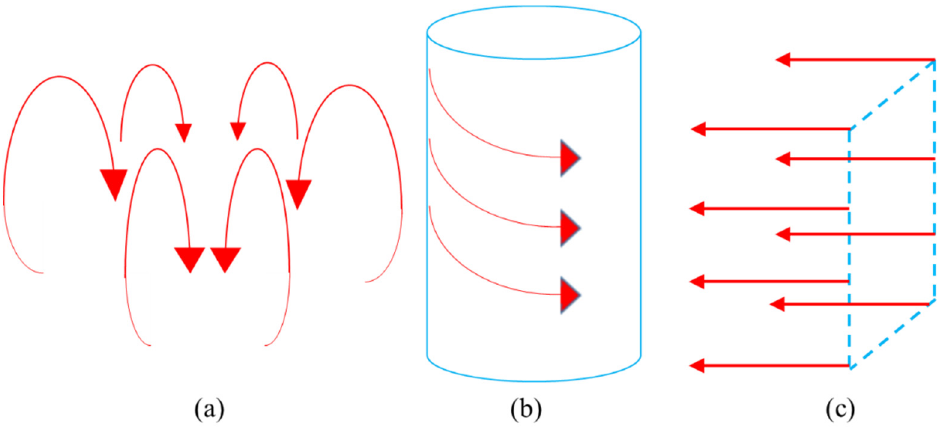
Figure 5. Macro images of the transverse section of processed plates ( a ) specimen 1, ( b ) specimen 2, ( c ) specimen 3, and ( d ) specimen 4.